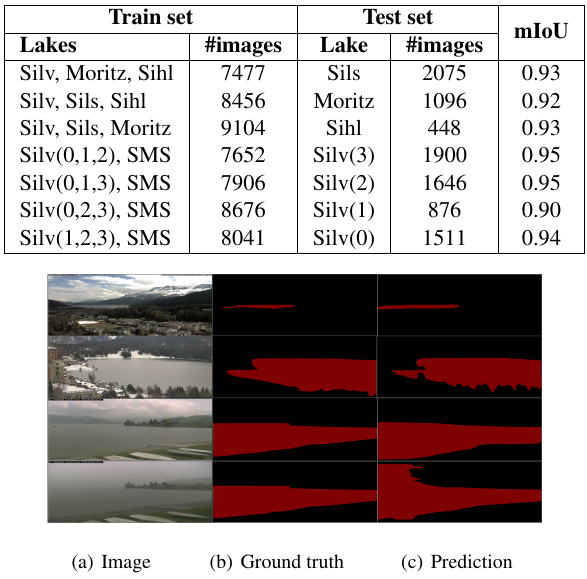
Table 2: Mean IoU (mIoU) values of the leave-one-cam-out ex- periments for lake detection. Silv(0,1,2,3) are the different cam- era angles for lake Silvaplana. SMS refers to {Sils, St. Moritz, Sihl}.